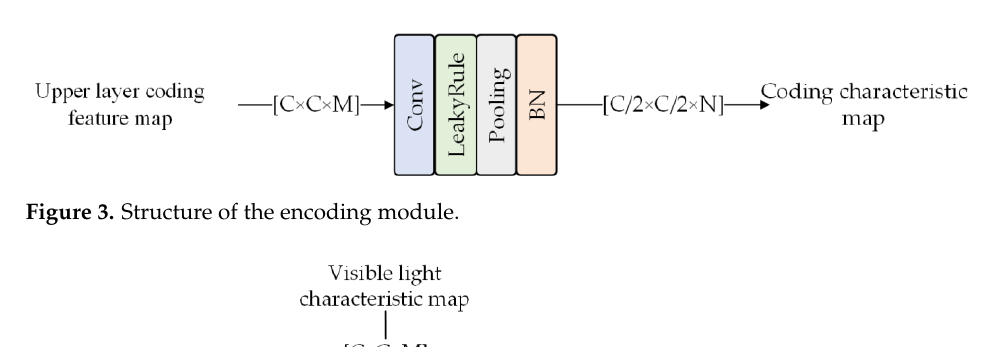
Figure 2. Structure of the generator.